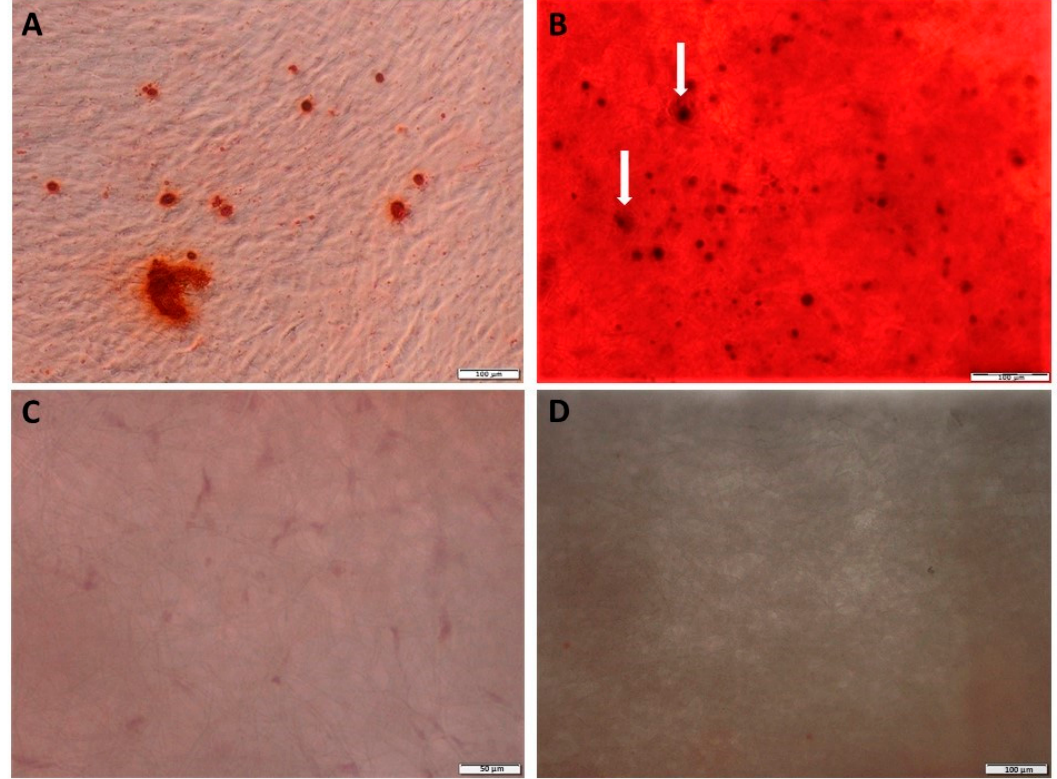
Figure 8. Alizarin Red S staining of hDPSCs on 2D culture dish and on PLCL scaffold after osteogenic differentiation. ( A ) Mineralized nodules after hDPSCs osteogenic differentiation in 2D culture, ( B ) hDPSCs are covered and embedded in mineralized matrix, and mineral deposits on PLCL surface stained by Alizarin Red S are visible (arrows). Control staining of ( C ) PLCL with non-differentiated hDPSCs and ( D ) PLCL without hDPSCs illustrate a lack of Alizarin Red S staining. Scale bar = 100 μ m ( A , B , D ) and 50 μ m ( C ).